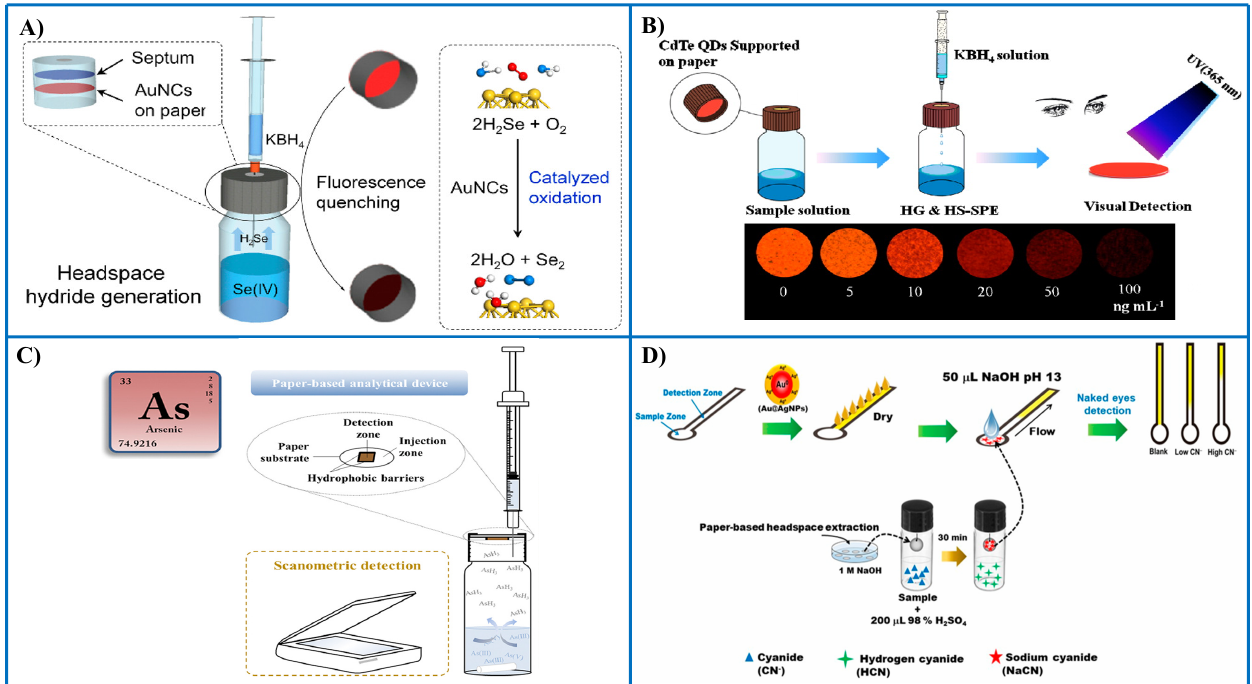
Figure 5. Representative examples of the combination of PADs and thin-film microextraction for the detection of different metal species and anions. ( A ) PAD with AuNCs as fluorescent probes and integrated with thin-film microextraction for sensing Se(IV) following hydride generation [79]; ( B ) PAD with CdTd QDs as nanoreceptors for the determination of Se(IV) following hydride generation [72]; ( C ) PAD integrated with thin-film microextraction for the determination of total As and speciation of As(III) and As(V) [93]; ( D ) distance-based microPAD for the determination of cyanide using Au/Ag NPs as probes; a prior preconcentration in a drop was carried out to improve sensitivity [94]. ( D ). Figure 5A–C is reproduced with permission of the American Chemical Society [72,79] and Elsevier